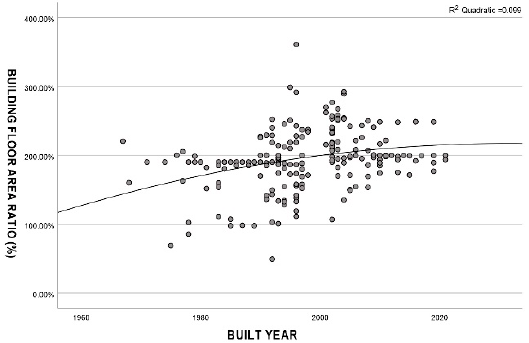
Figure 7. FAR of sample buildings per construction years; each dot represents sample buildings.